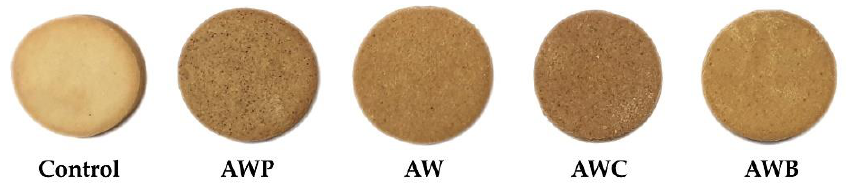
Figure 3. External aspect of the evaluated cookies. Control—wheat flour (100%) and butter (100%); AWP—maize flour (50%), almond flour (33%), walnut flour (14%), poppy flour (3%), walnut oil (70%) and poppy oil (30%); AW—maize flour (60%), almond flour (28%), walnut flour (12%) and walnut oil (100%); AWC—almond flour 823%), walnut flour (12%), chia flour (5%), almond oil (50%) and walnut oil (50%); AWB—maize flour (82%), walnut flour (12%), almond flour (6%), butter (50%) and walnut oil (50%).